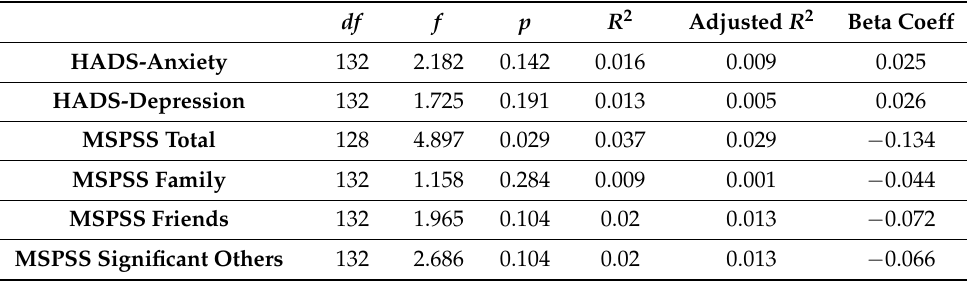
Table 4. Linear regressions for T1 life satisfaction with the hospital anxiety and depression scale (HADS) and multidimensional scale of perceived social support (MSPSS) ( n =